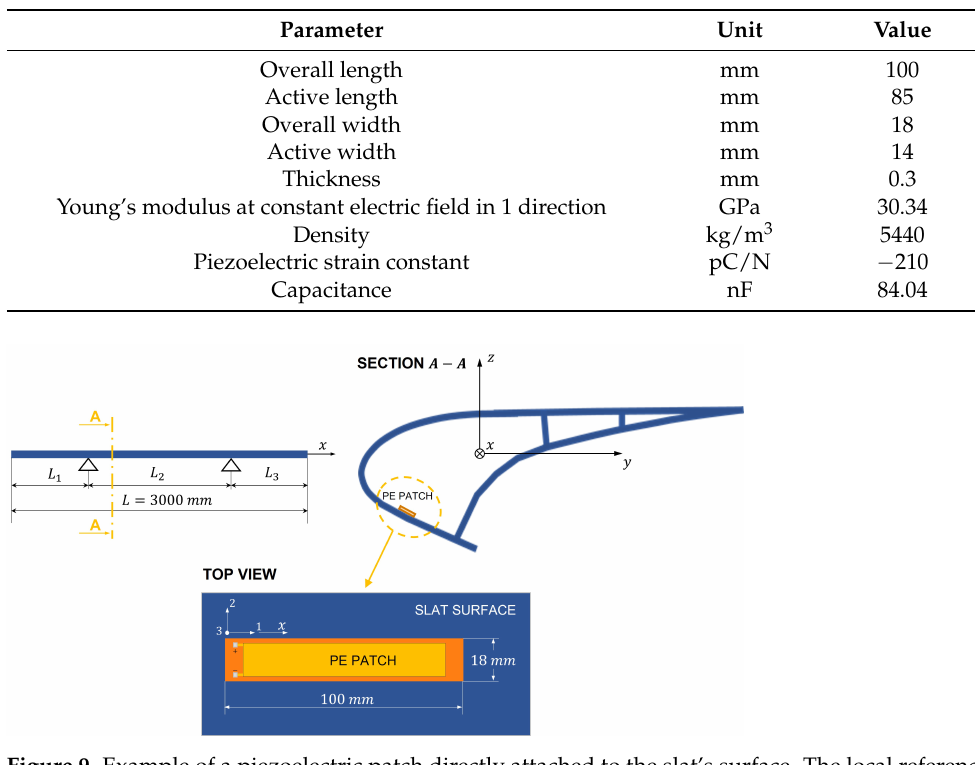
Figure 9. Example of a piezoelectric patch directly attached to the slat’s surface. The local reference frame of the patch has axes (1, 2, 3), whereas the global reference frame has axes ( x , y , z